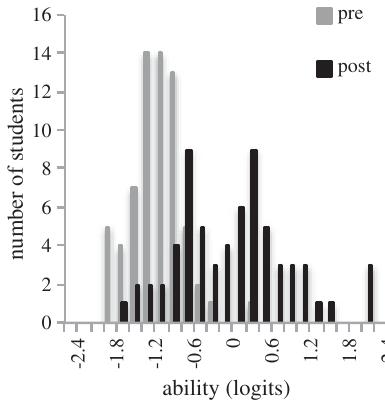
FIG. 31. The pre- and postability histograms for class 17.